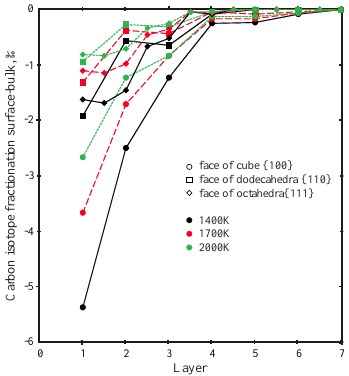
Figure 2. Results of ab initio calculation of isotope equilibrium of carbon positions on particular crystallographic face of diamond crystal in comparison with deeply sited positions in diamond lattice (bulk) at different